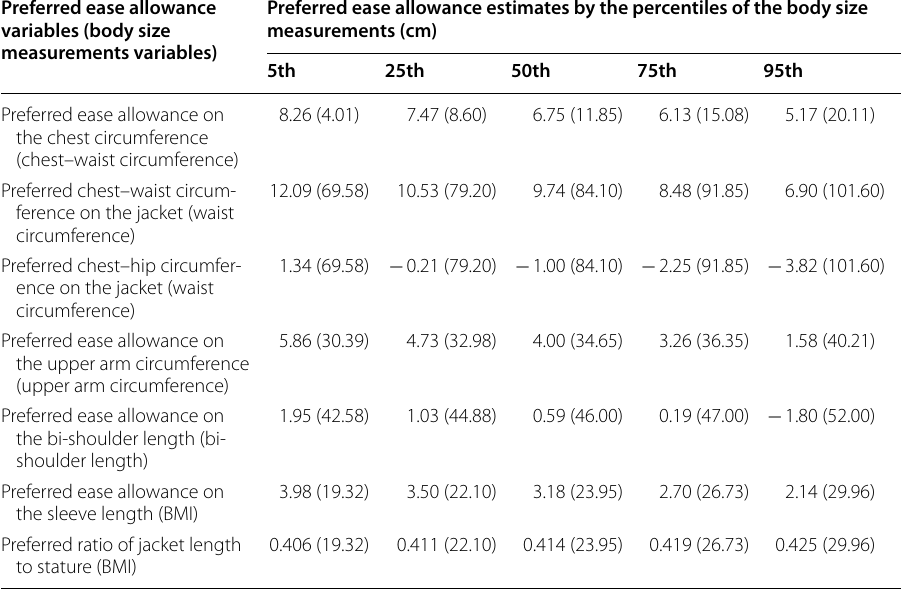
Table 7 Preferred ease allowance estimates by the percentiles of body size measurements Preferred ease allowance variables (body